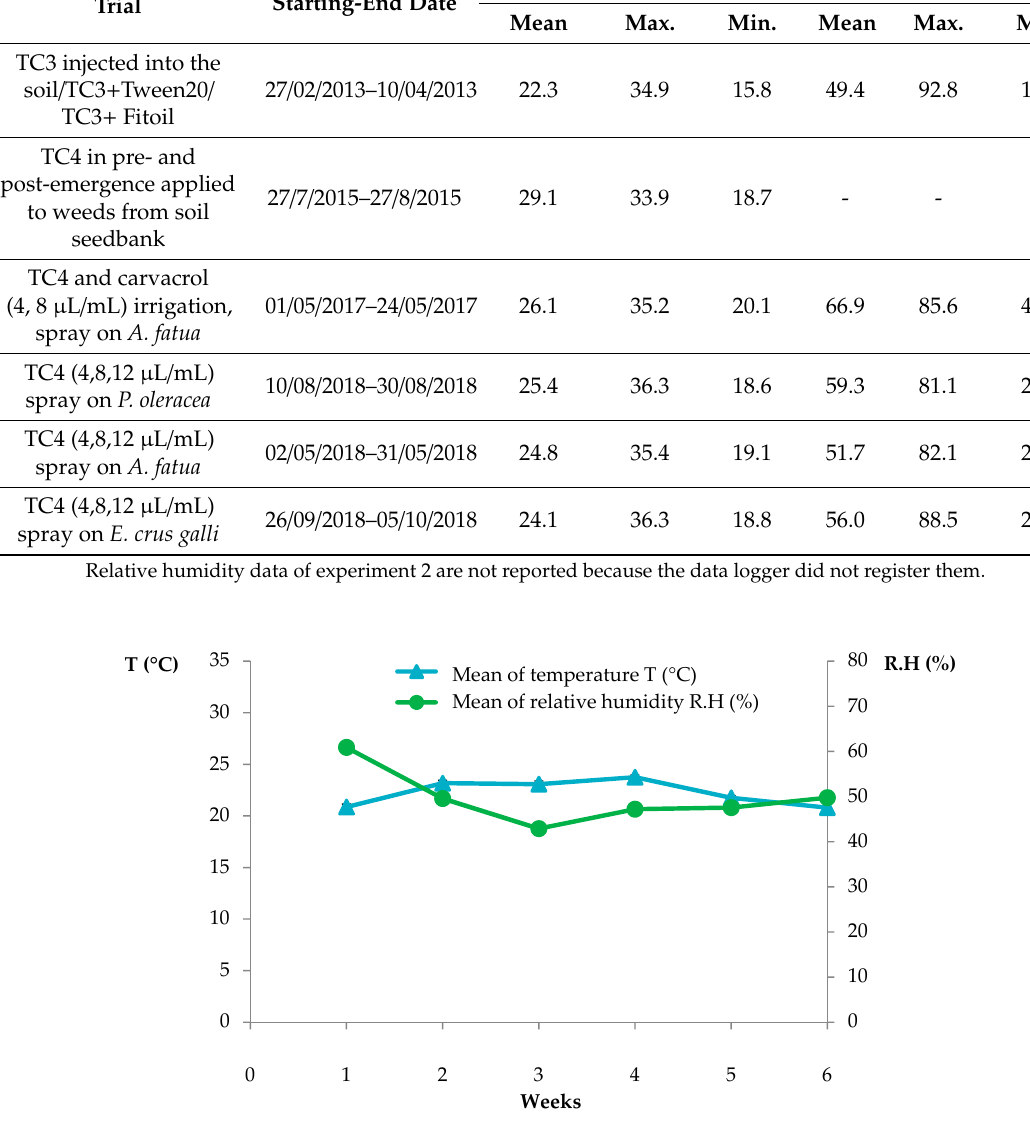
Figure 12. Greenhouse conditions during the experiment testing TC3 EO application directly injected into the soil or supplied with water, emulsified with Tween 20 or Fitoil.